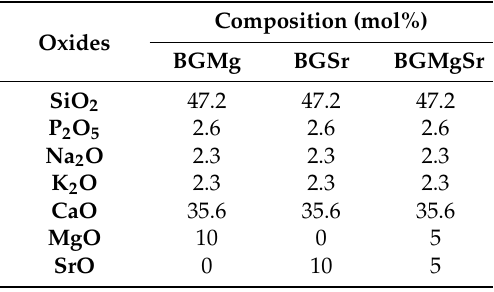
Table 1. Compositions (in oxides mol%) of the produced glasses.